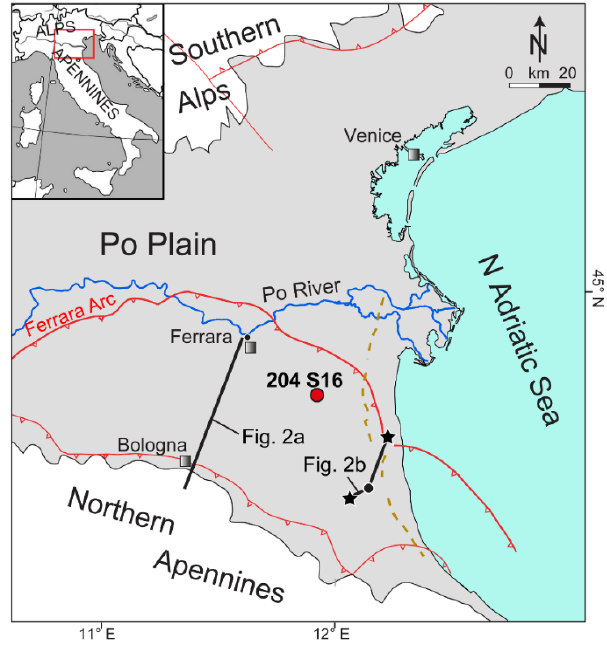
Figure 1. Location map of the studied core 204 S16 (red dot). The main Alpine and Apennine structures of the eastern sector of the Po Plain (modified from [39]) are reported along with the seismic and stratigraphic profiles showed in Figure 2a,b. Black stars indicate deep (>100 m) continuously cored boreholes cores with pollen data. The orange dotted line corresponds to the innermost outcropping beach-ridges, dated to the pre-Etruscan times (>2800 years BP) [40].